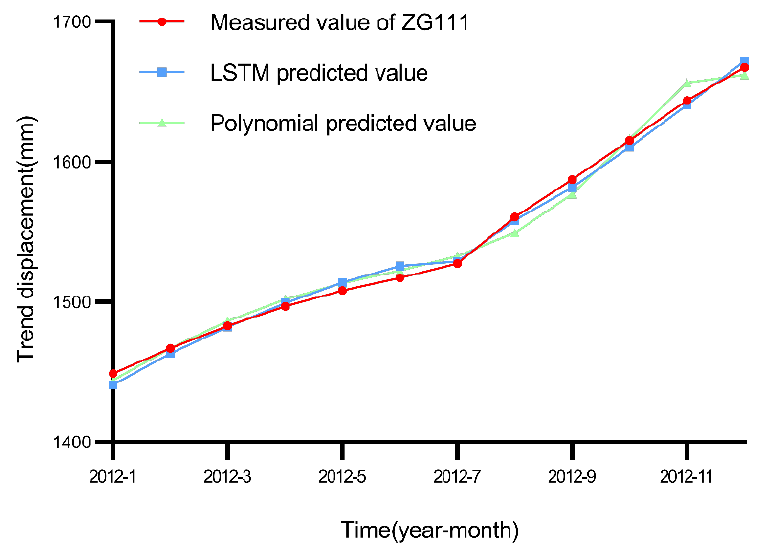
Figure 17. Trend displacement predicted results of ZG118.